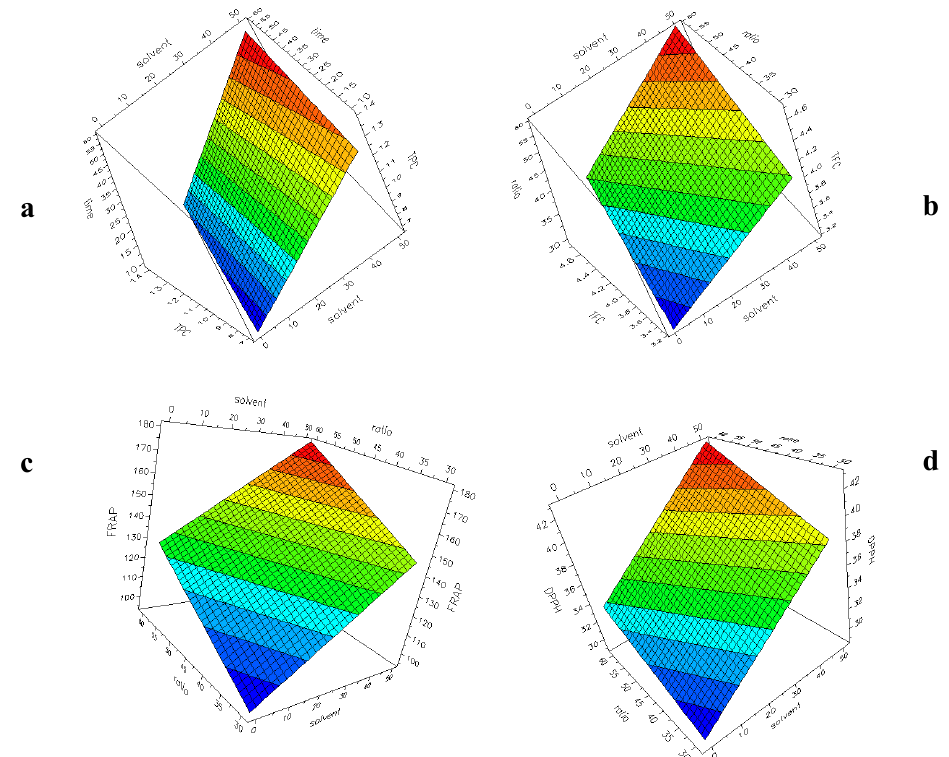
Figure 3. UAE experimental design. Surface plot showing the responses: ( a ) TPC (60:1, 60 °C); ( b ) TFC (10 min, 30 °C); ( c ) FRAP (10 min, 30 °C); ( d ) DPPH (60 min, 60 °C).